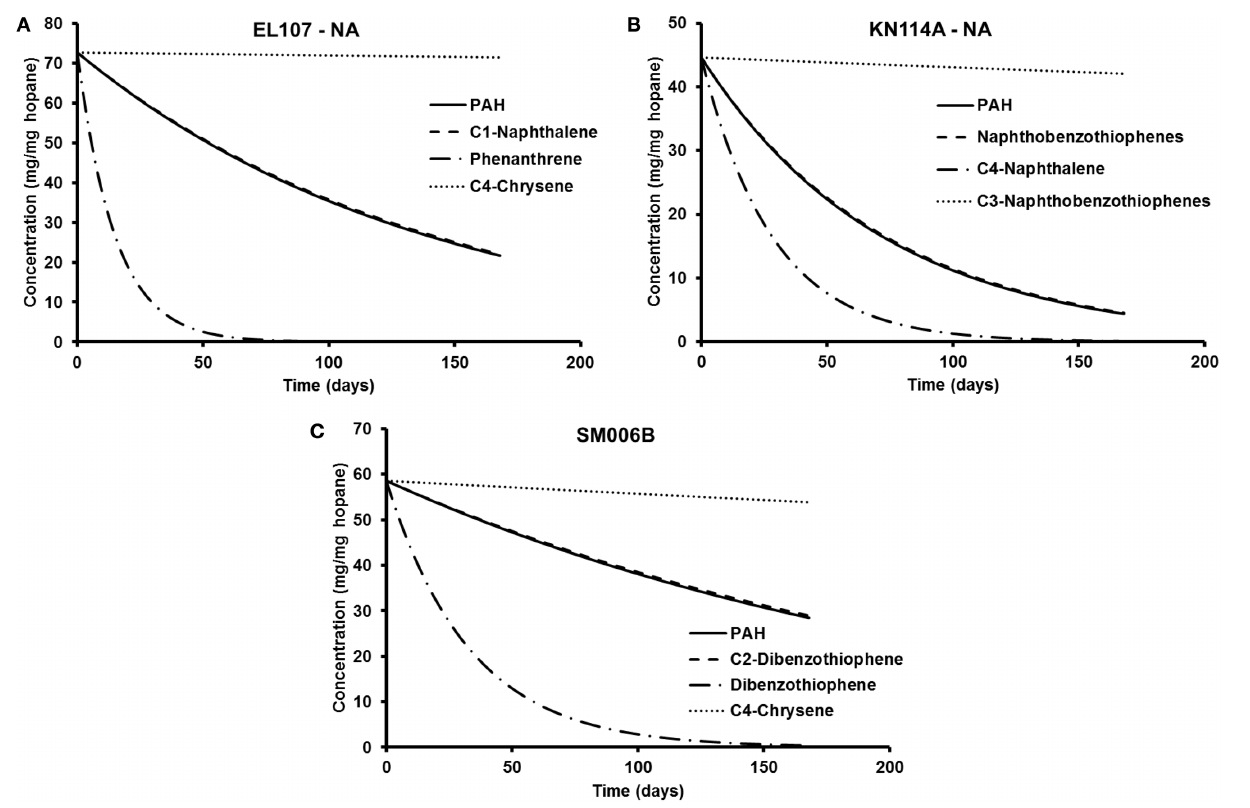
FIGURE 8 | Comparison of the temporal variation for different compounds in natural attenuation experiments for (A) EL107, (B) KN114A, and (C) SM006B.